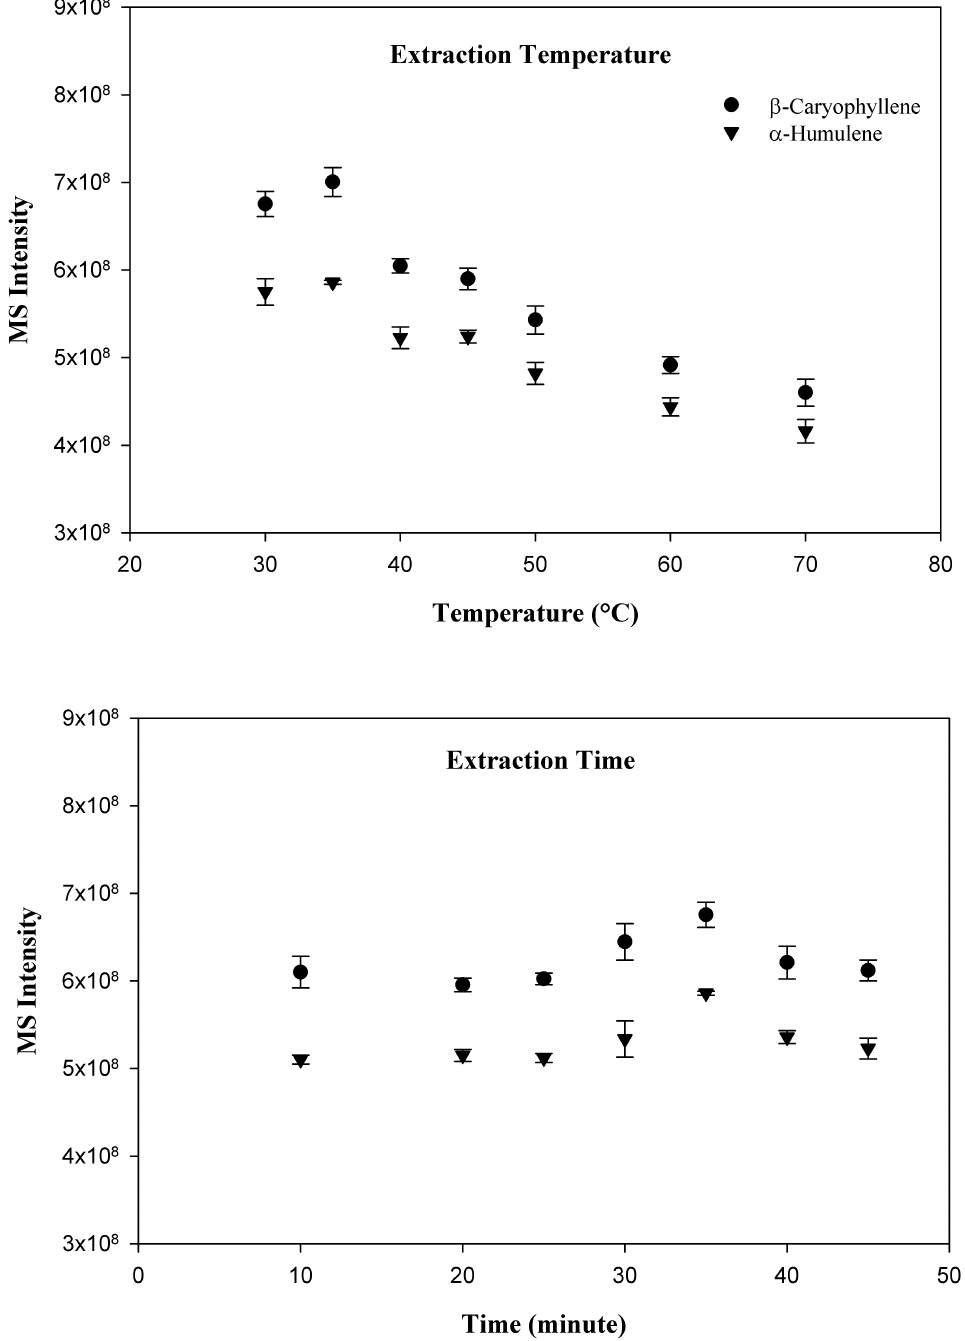
Figure 1. SPME method optimization in terms of extraction temperature and